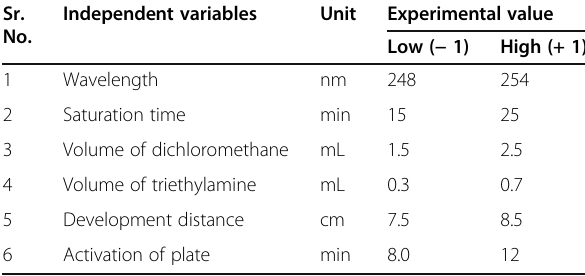
Table 1 Level of independent variables selected in Plackett- Burman design for screening the independent